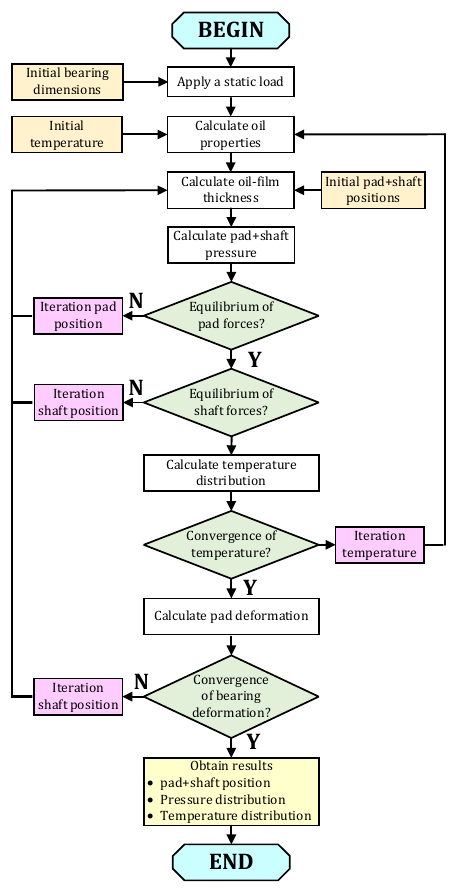
Figure 4. Flowchart of the Matlab code.